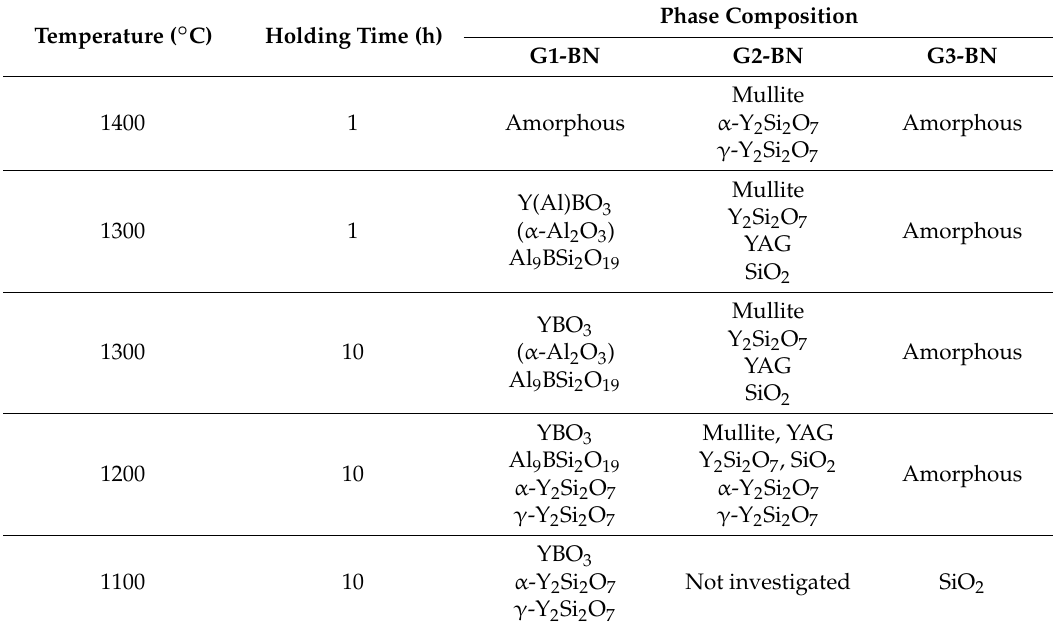
Table 2. Phase composition of the glass matrix of the glass–c-BN composites as a function of heat treatment conditions determined by XRD measurement.